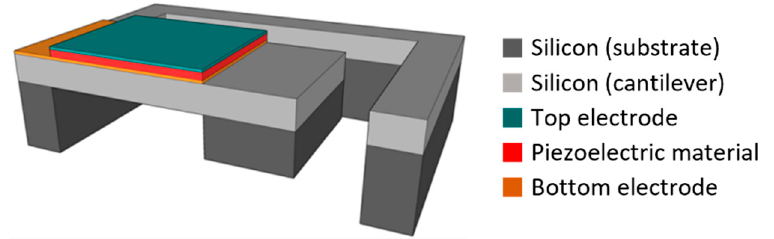
Figure 1. Schematic illustration of a MEMS piezoelectric vibrational energy harvester. Typical designs comprise a movable structure (cantilever) made of silicon with a piezoelectric transducer patch on top and a passive tip mass made of silicon.